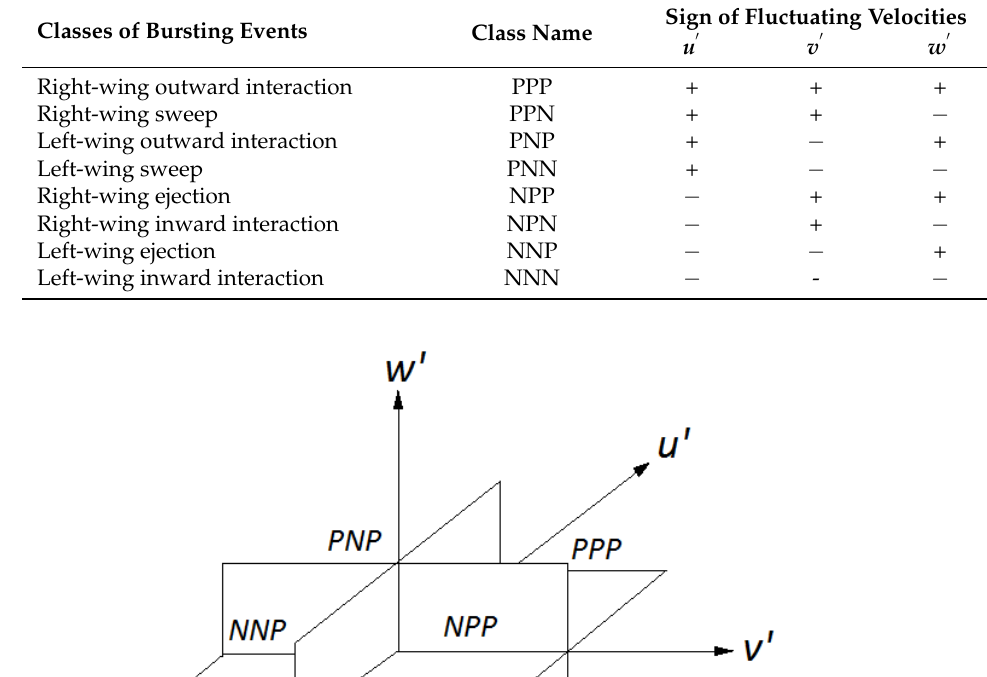
Table 1. Three-dimensional analysis of bursting events in the octant analysis.